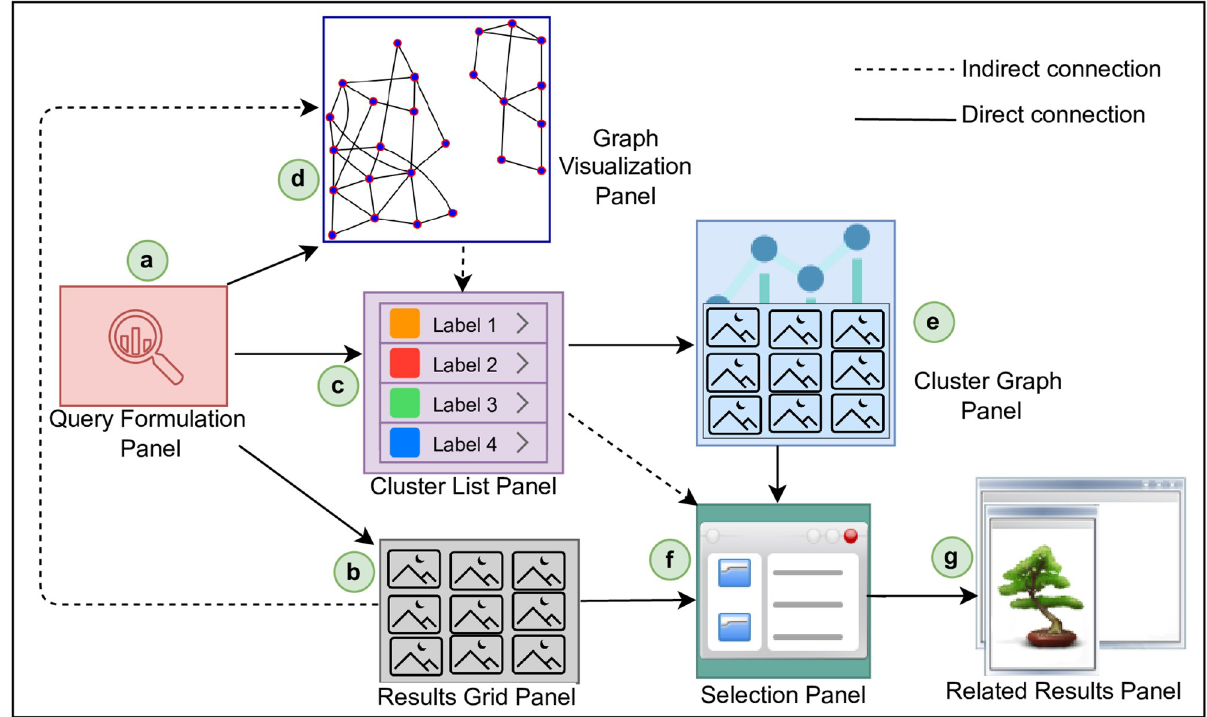
Fig 6. Schematic representation of user interaction paradigm; information need expression ( a ), the exploration initiation ( b ), linear navigation ( c ), and non-linear navigation ( d ).